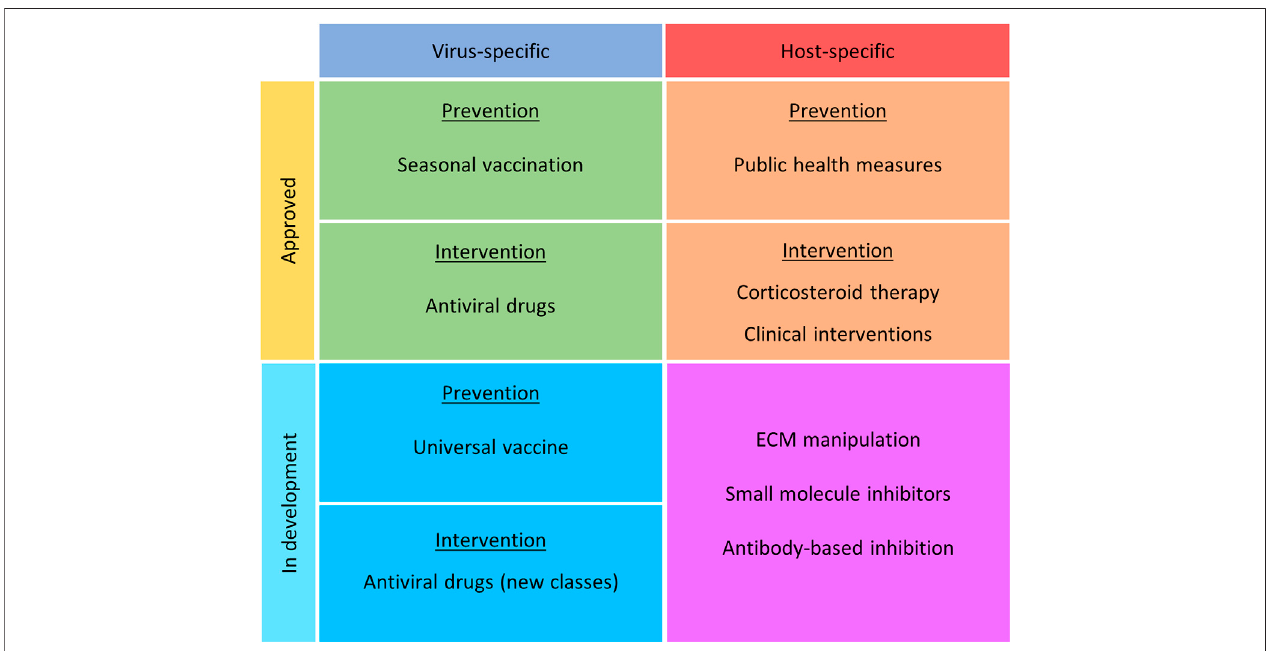
FIGURE 1 | Current and emerging intervention strategies for the prevention and treatment of in fl uenza virus infection. Strategies have been noted as virus or host speci fi c, approved or in development, and nature of treatment (prevention or intervention).